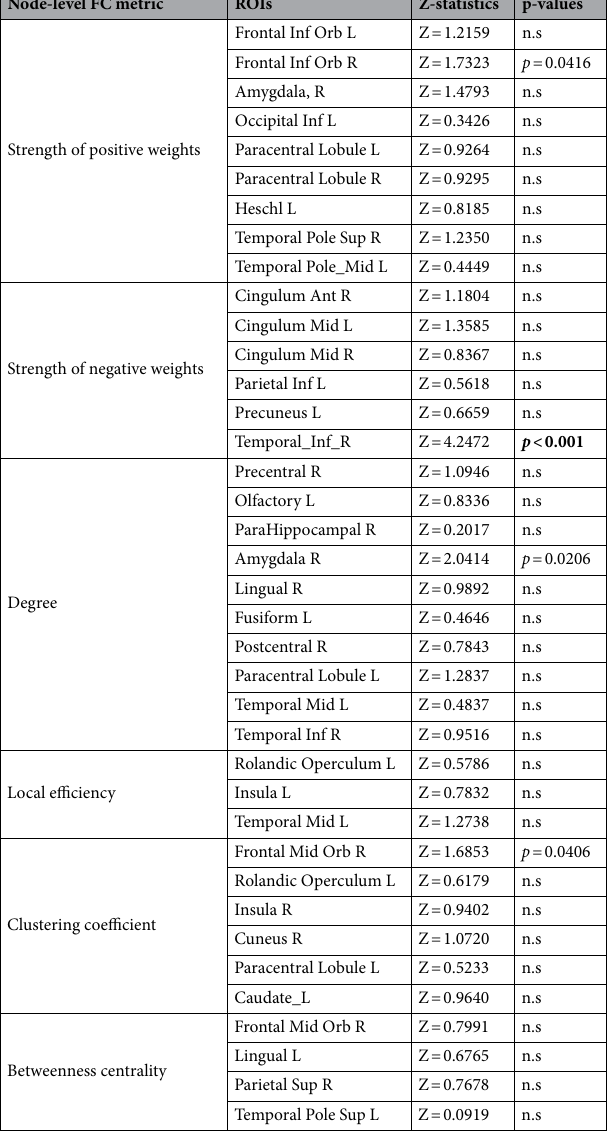
the strength of positive weights in right inferior orbitofrontal cortex, (2) the strength of negative weights in the right inferior temporal gyrus, (3) the degree of connections of right amygdala, and (4) the clustering coefficient of right middle orbitofrontal cortex. Of note, correlation differences that emerged for the strength of negative weights in right inferior temporal gyrus remained significant after Bonferroni correction (Z = 4.25, p Bonf < 0.001). ADE model. The test of ADE model applicability to node-level FC metrics highlighted a small number of ROIs, associated with specific features, influenced by ADE factors. The clustering coefficient was the feature with the highest number of ROIs (equal to 8.89% of the total) suitable for ADE modelling. Conversely, the strength of negative weights and betweenness centrality exhibited ADE effects in the minimum number of ROIs, account- ing for 2.22% of the total. For each nodal feature, the ROIs for which the ADE model was suitable are listed in Table 3, together with the corresponding ADE coefficients and “broad-sense” heritability estimates. Significant correlation differences between MZ and DZ twins were observed only in the strength of positive weights in right middle temporal pole (Z = 1.66, p = 0.048).